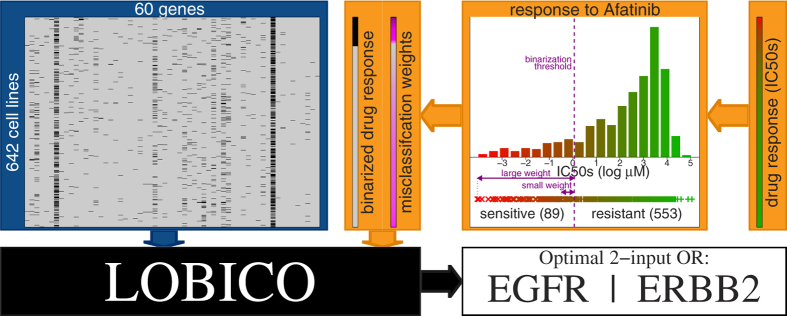
Workflow of LOBICO.LOBICO has two main inputs: (1) a binary matrix of samples by features (depicted in the blue box). Here, the binary matrix contains the mutation status of 60 cancer genes measured across 642 cancer cell lines. (2) a continuous vector with a value for each of the samples (depicted in the orange boxes). In this case, the vector contains the IC50 of each cell line in response to Afatinib, an EGFR/ERBB2 inhibitor. The continuous vector is transformed into a binary vector and a sample-specific weight vector using a binarization scheme. Particularly, the IC50s are binarized using a threshold leading to a set of sensitive and a set of resistant cell lines. The distances of the original IC50s to the binarization threshold are represented in the weight vector, which is normalized per class. Then, LOBICO finds the optimal logic model of features (gene mutations) that minimizes the total weight of misclassified samples (cell lines). In this case, the optimal 2-input OR logic formula is ‘EGFR OR ERBB2’ (depicted in the white box).